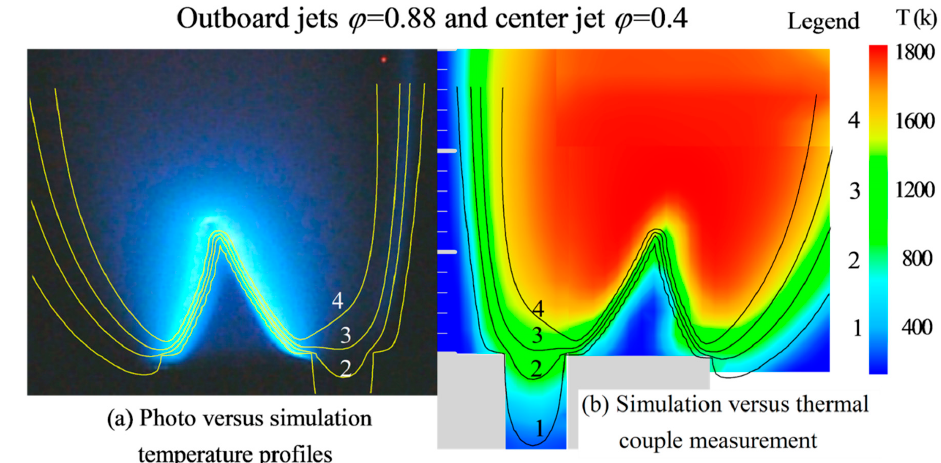
Figure 12. Comparisons of the calculated temperature isopleths against ( a ) the photo and ( b ) the experimental thermocouple measured temperature distribution of the outer flame and half of the center flame. The burning conditions were for the center flame at φ = 0.4 and outer flame at φ = 0.88. The average jet exit speed was equal to 1 m/s for both center and outer flames.